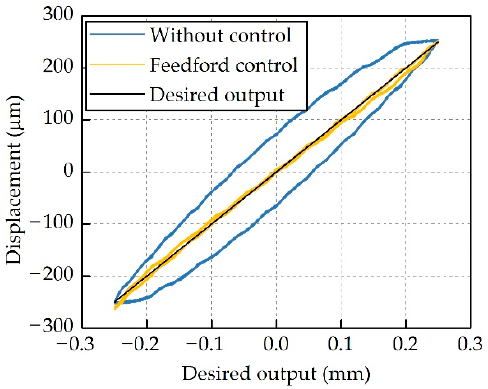
Figure 9. Hysteresis suppression by using feedforward compensator.